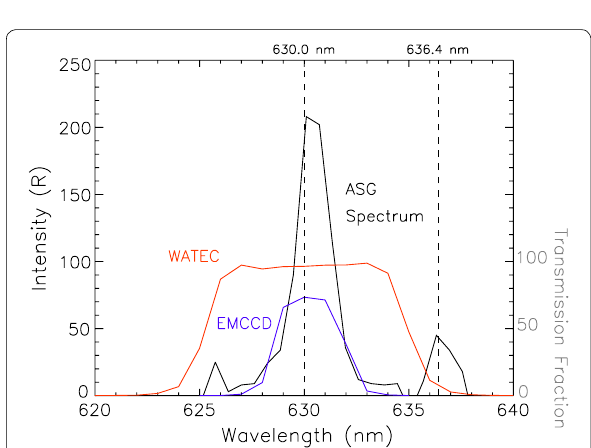
Fig. 6 Filter characteristics of EMCCD (blue) and WATEC (red) ASIs. The black curve shows the airglow spectrum obtained by the Auroral Spectrograph (ASG) operating in Svalbard at the same